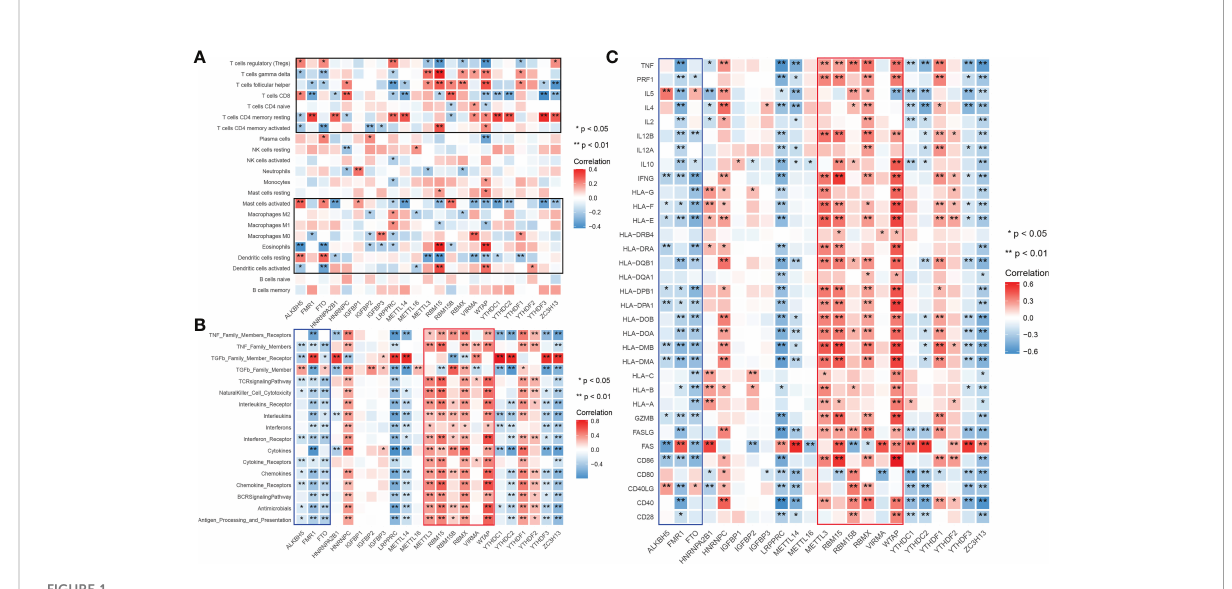
FIGURE 1 Landscape of correlationship between m6A regulators and immune characteristics. (A) Correlation heatmap of m6A regulators and immune cells. (B) Correlation heatmap of m6A regulators and immune gene categories. (C) Correlation heatmap of m6A regulators and rejection key genes. m6A regulators signi fi cantly correlated immune cells clustered in the black wireframe; Immune gene categories or rejection key genes signi fi cantly positive correlated m6A regulators clustered in the red wireframe; Immune gene categories or rejection key genes signi fi cantly negative correlated m6A regulators clustered in the blue